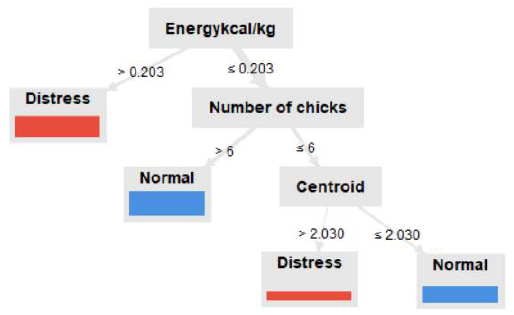
Figure 4. Tree-like model to predict broiler chick well-being based on data on vocalization and number of birds in the group.